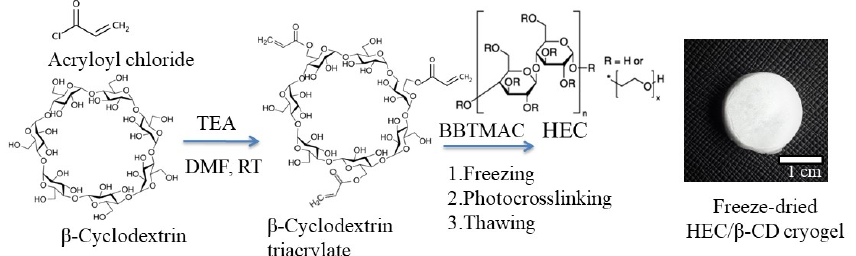
Figure 1. Synthesis of HEC/β-CD cryogel via cryogenic treatment and photochemical crosslinking in a frozen state.